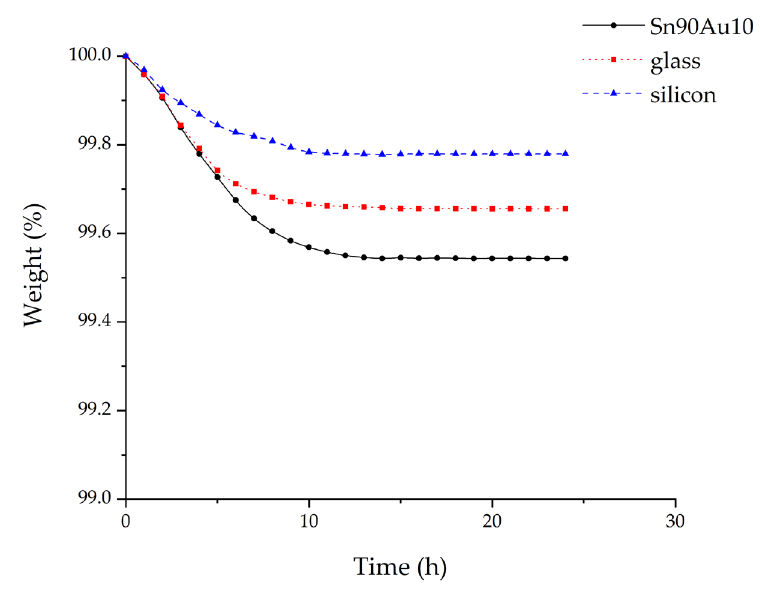
◦ C of Sn90Au10 solder, glass and